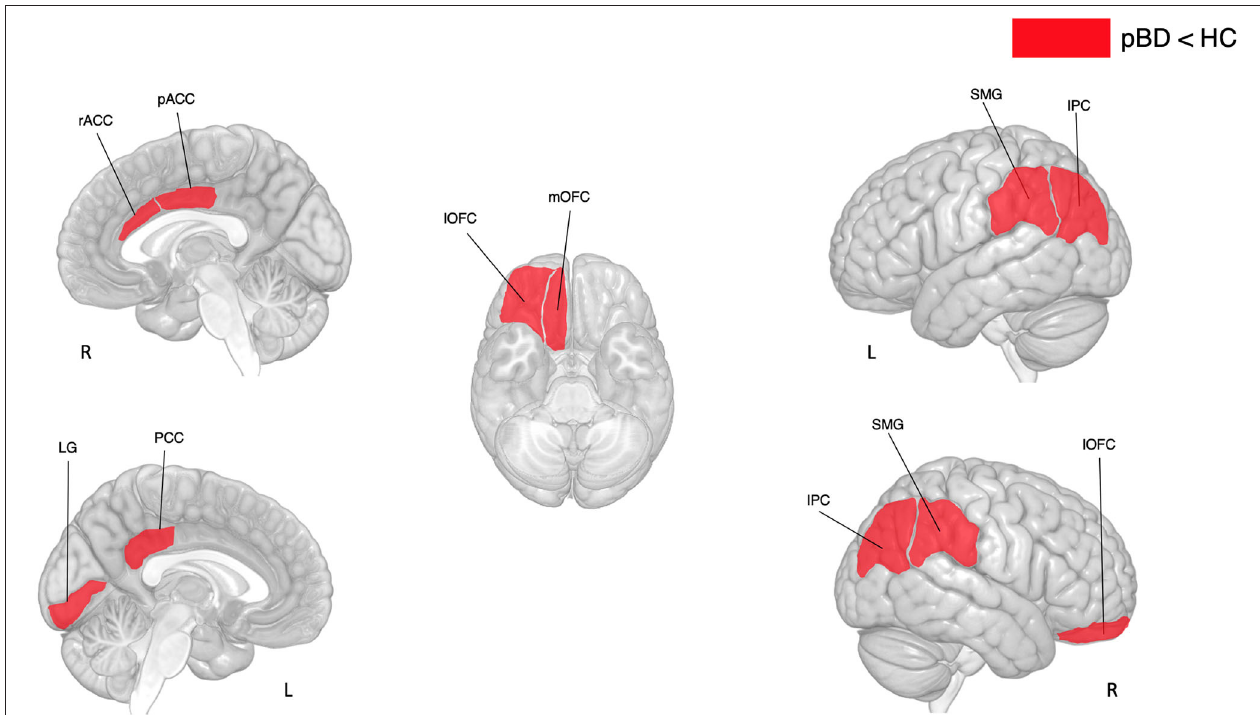
FIGURE 2 | Differences in cortical thickness between subjects with pBD and HC. pBD, pediatric bipolar disorder; HC, healthy controls. IPC, inferior parietal cortex; SMG, supramarginal gyrus; LG, lingual gyrus; lOFC, lateral orbitofrontal cortex; mOFC, medial orbitofrontal cortex; pACC, posterior anterior cingulate cortex; PCC, posterior cingulate cortex; rACC, rostral anterior cingulate